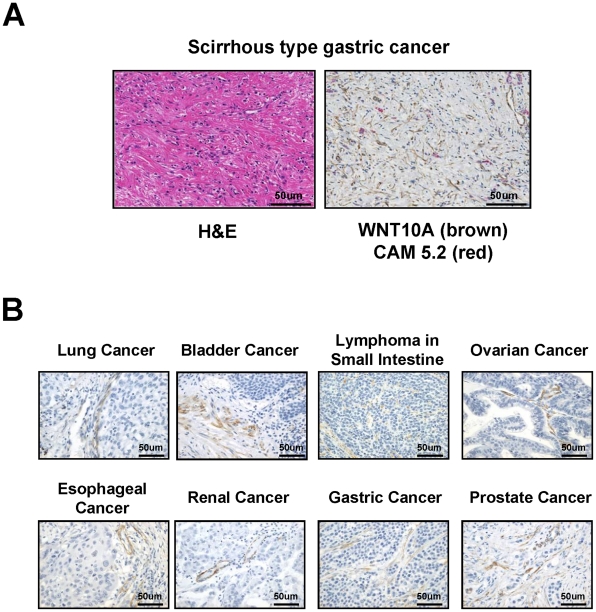
Immunohistochemical analysis of WNT10A expression in various human cancer specimens.(A) H&E and double immunohistochemical staining of scirrhous-type signet-ring carcinoma cells. 3,3′-Diaminobenzidine (DAB) was used as chromogen for WNT10A staining (brown color) and Vulcan fast red was used for cytokeratin CAM 5.2 staining (red color). Anti-cytokeratin CAM 5.2 was used for staining of signet-ring cell carcinoma cells. (B) WNT10A expresses cancer stroma cells in various human cancer specimens. 3,3′-Diaminobenzidine (DAB) was used as chromogen for WNT10A staining (brown color).